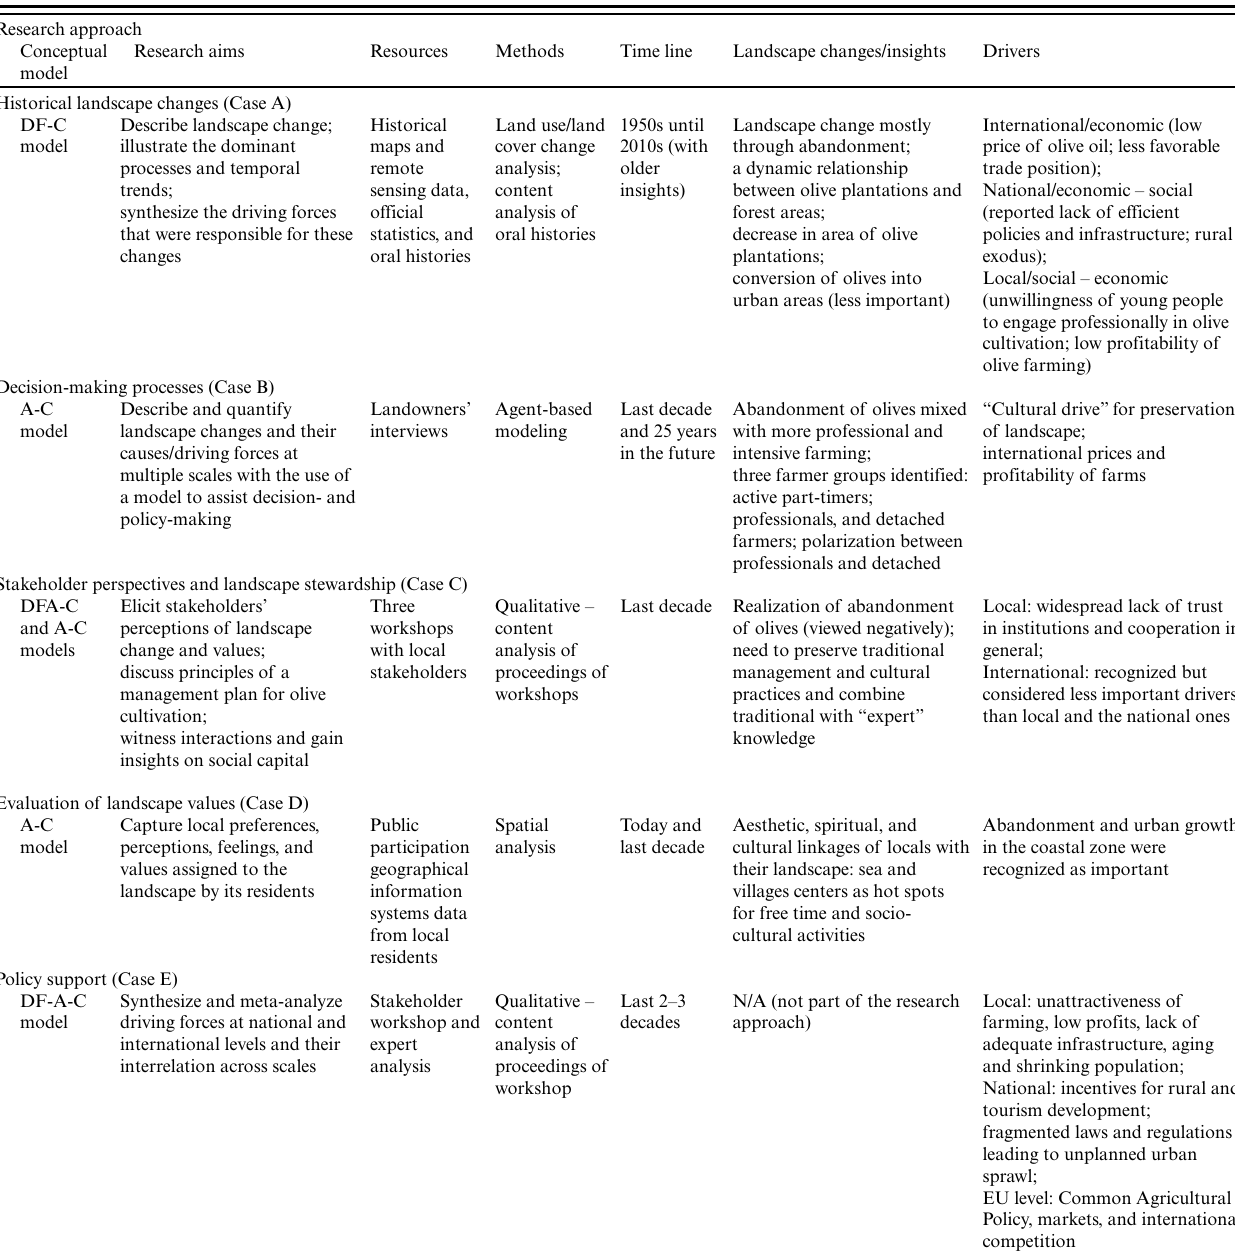
Table 1 . Summary of different research approaches, changes detected, and driving